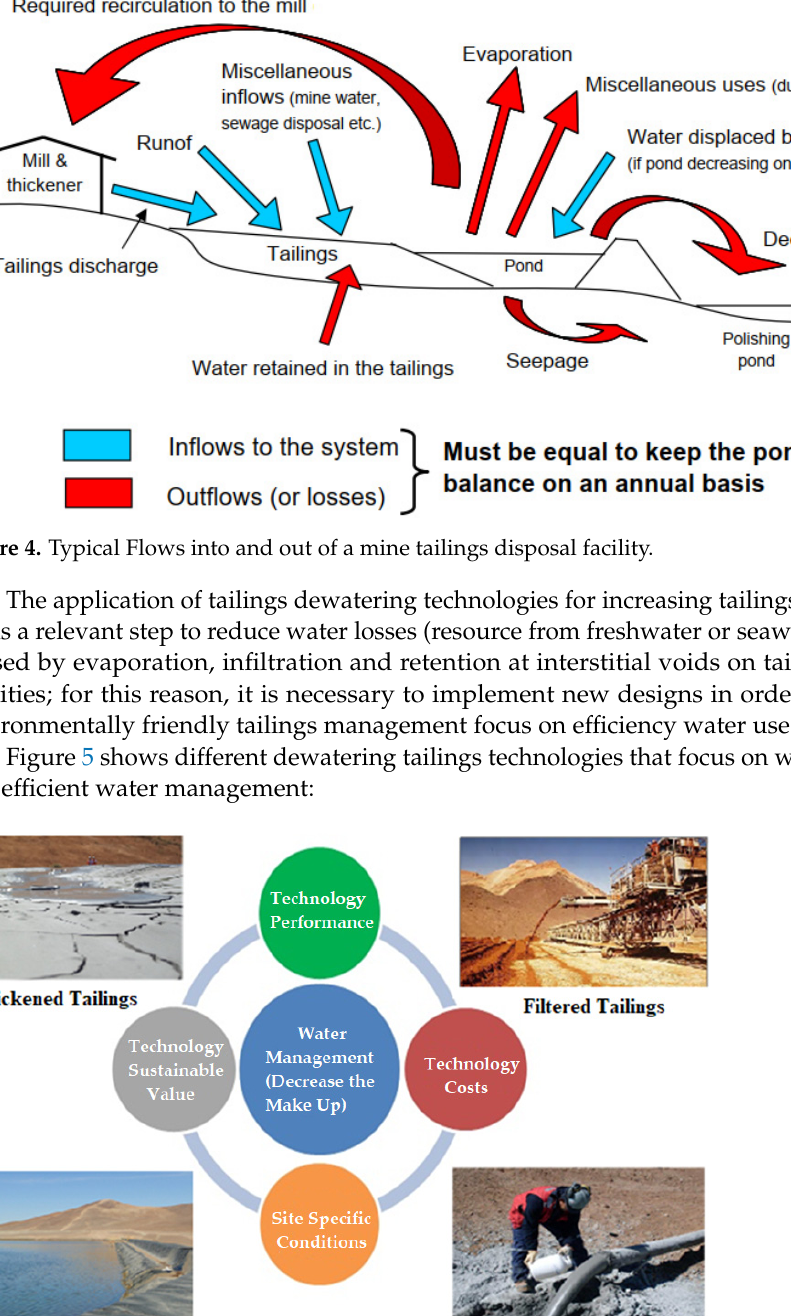
Figure 3. Typical flows into and out of a mill and thickening mining plant.